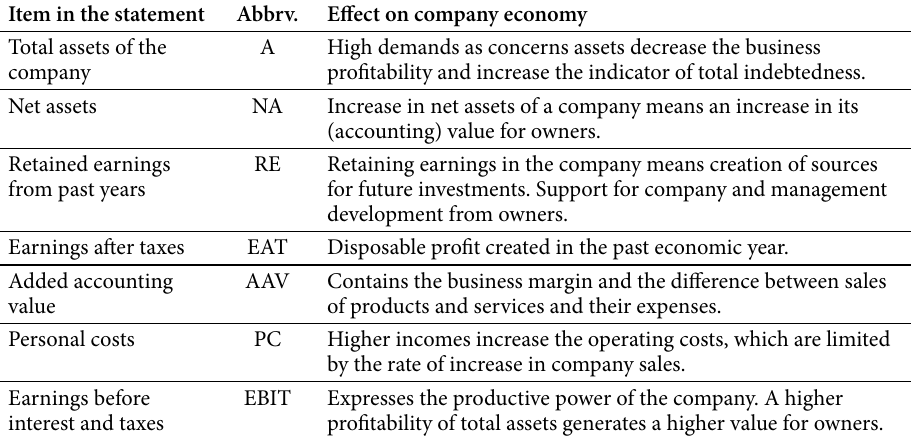
Table 1. The overview of data extracted from financial statements of companies in the monitored period Item in the statement